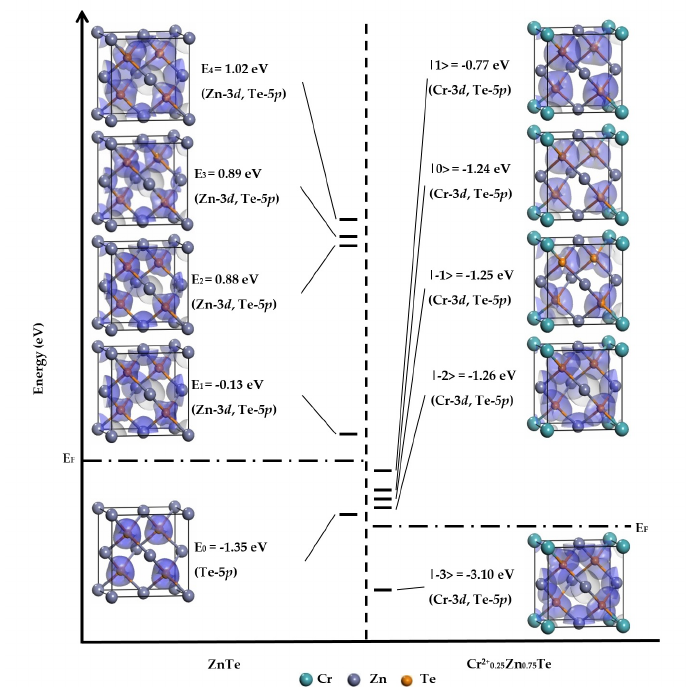
Figure 3. Left (Right) panel: HOMO and LUMO slab isosurfaces of 8-atom ZnTe (Cr 2 + 0.25 Zn 0.75 Te) cells arranged by energy and denoted by the shade of purple. The atoms are represented by spheres: Cr (green), Zn (gray, dark), and Te (yellow).